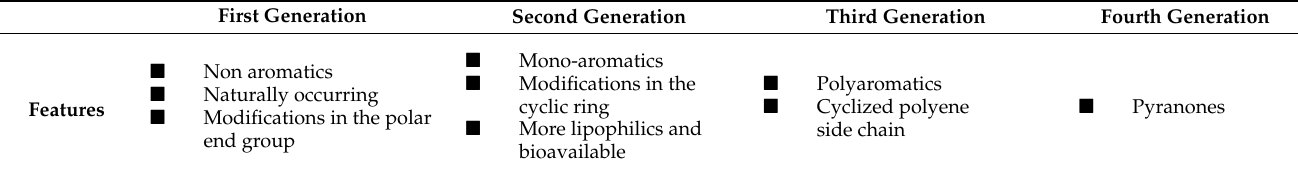
Table 1. Retinoids classification: retinoids are classified into four generations based on their chemical modification [20–22]. First